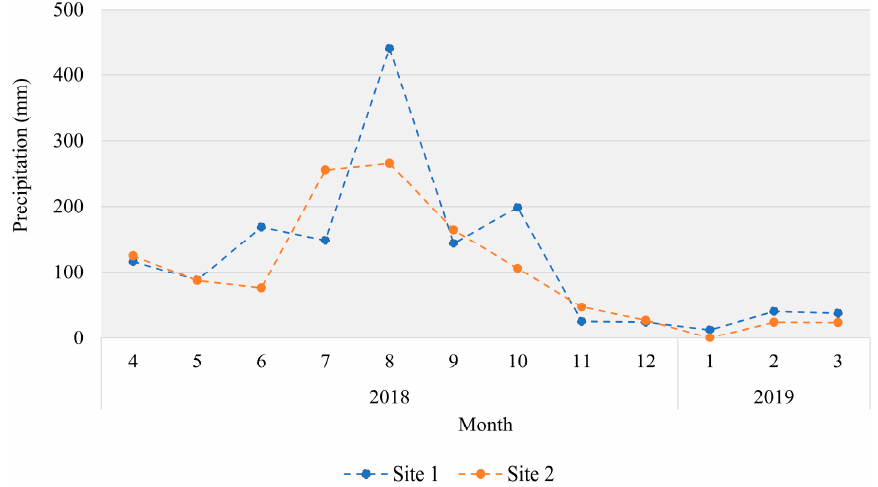
Figure 11. Monthly accumulated precipitation at each study site where the background area indicates the average monthly precipitation values of the two test sites. Precipitation data are an accumulated sum of the measurements.